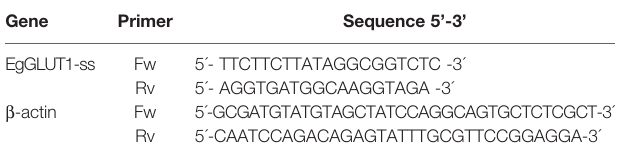
TABLE 2 | EgGLUT1-ss Gene primer